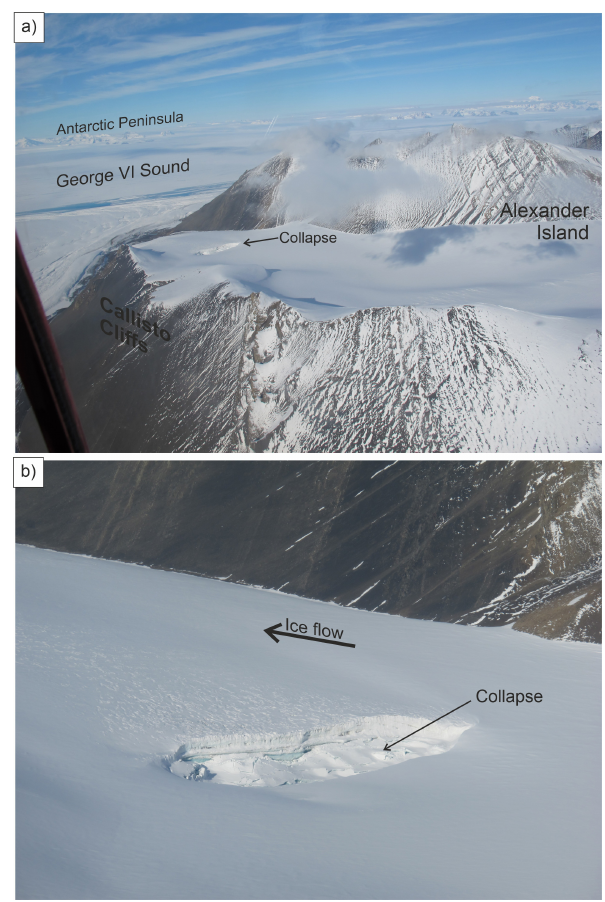
Figure 10. Ice collapse structure at Callisto Cliffs on Alexander Is- land first observed in March 2022. (a) View looking approximately southeast towards George VI Sound. (b) Zoom on collapse struc- ture. Note extensive surface crevassing on the downstream side of the structure which may be the result of supraglacial meltwater or deformation of the surface over an outflow